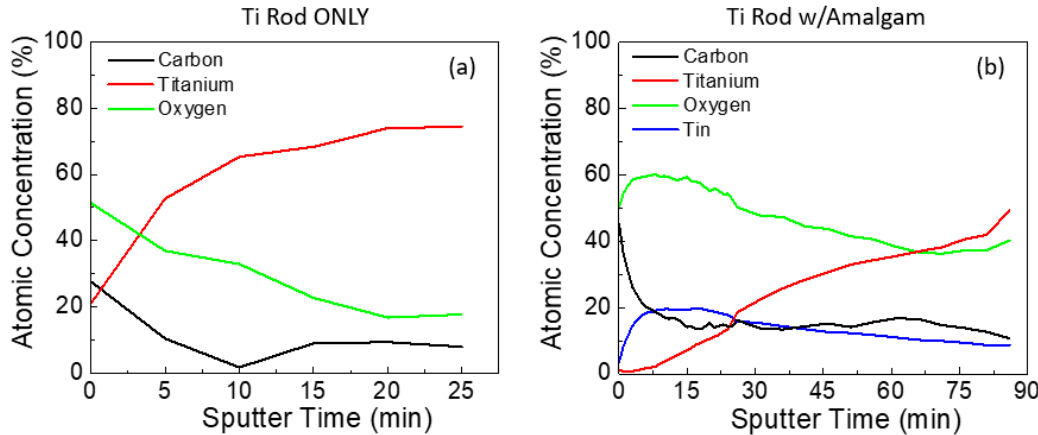
Figure 3. XPS depth profiles of the Ti rod immersed at pH 2 ( a ) without amalgam and ( b ) with